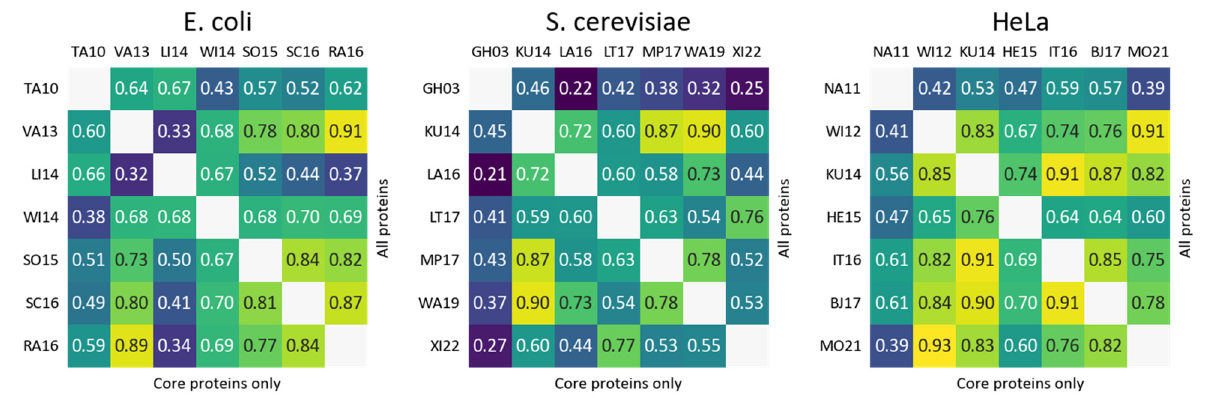
Figure 4. Pairwise Pearson’s correlation of protein levels between individual datasets for all shared proteins ( top right half ) or core proteins ( lower left half ).